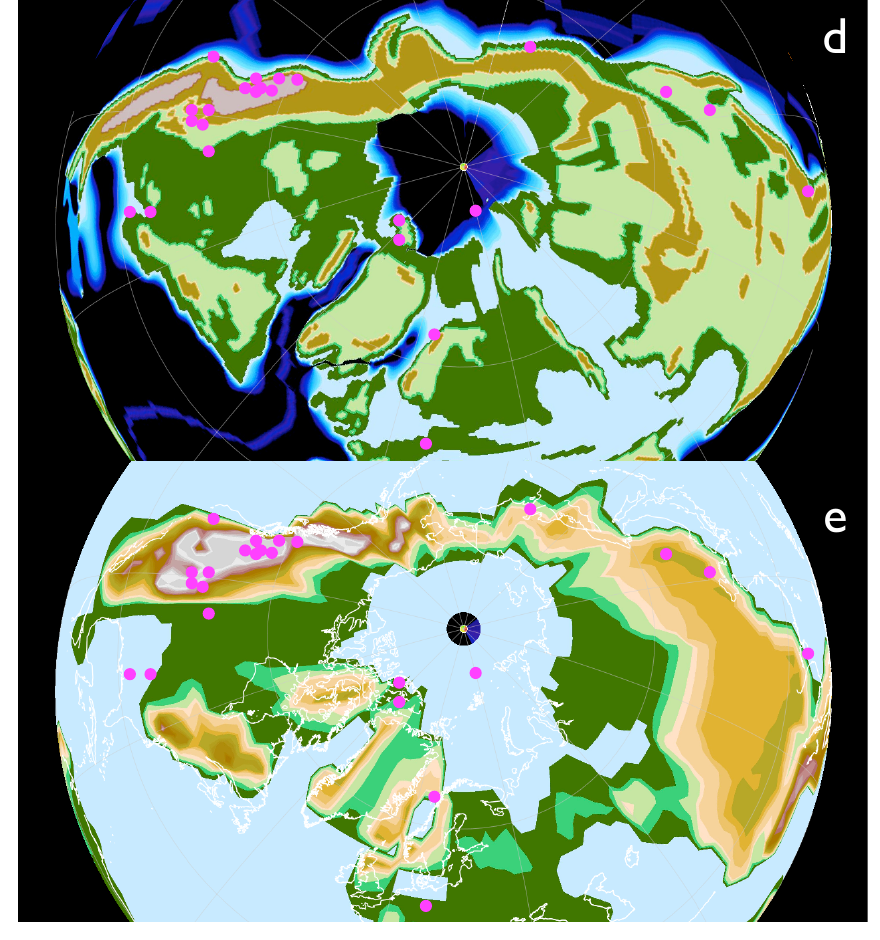
Fig. 1d − e. Figure 1 continued, see Fig. 1a for description.